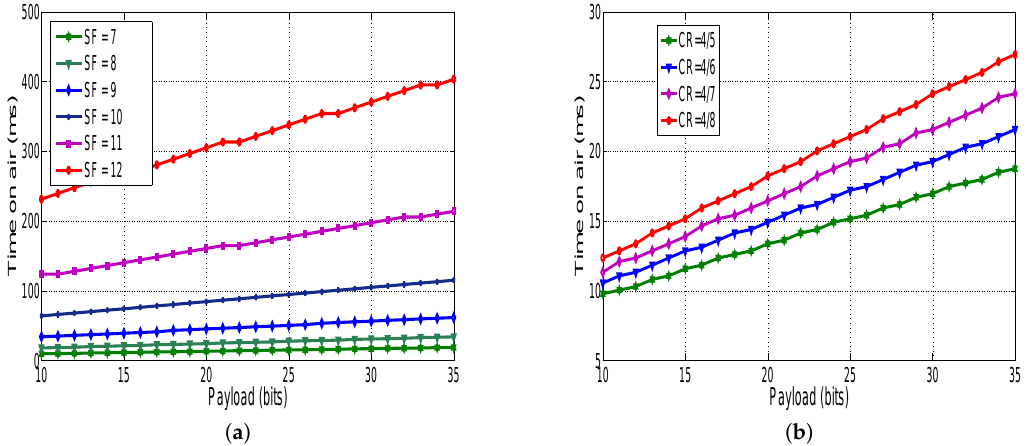
Figure 8. ( a ) Time on air vs. payload at different SF ; and ( b ) time on air vs. payload at different CR .